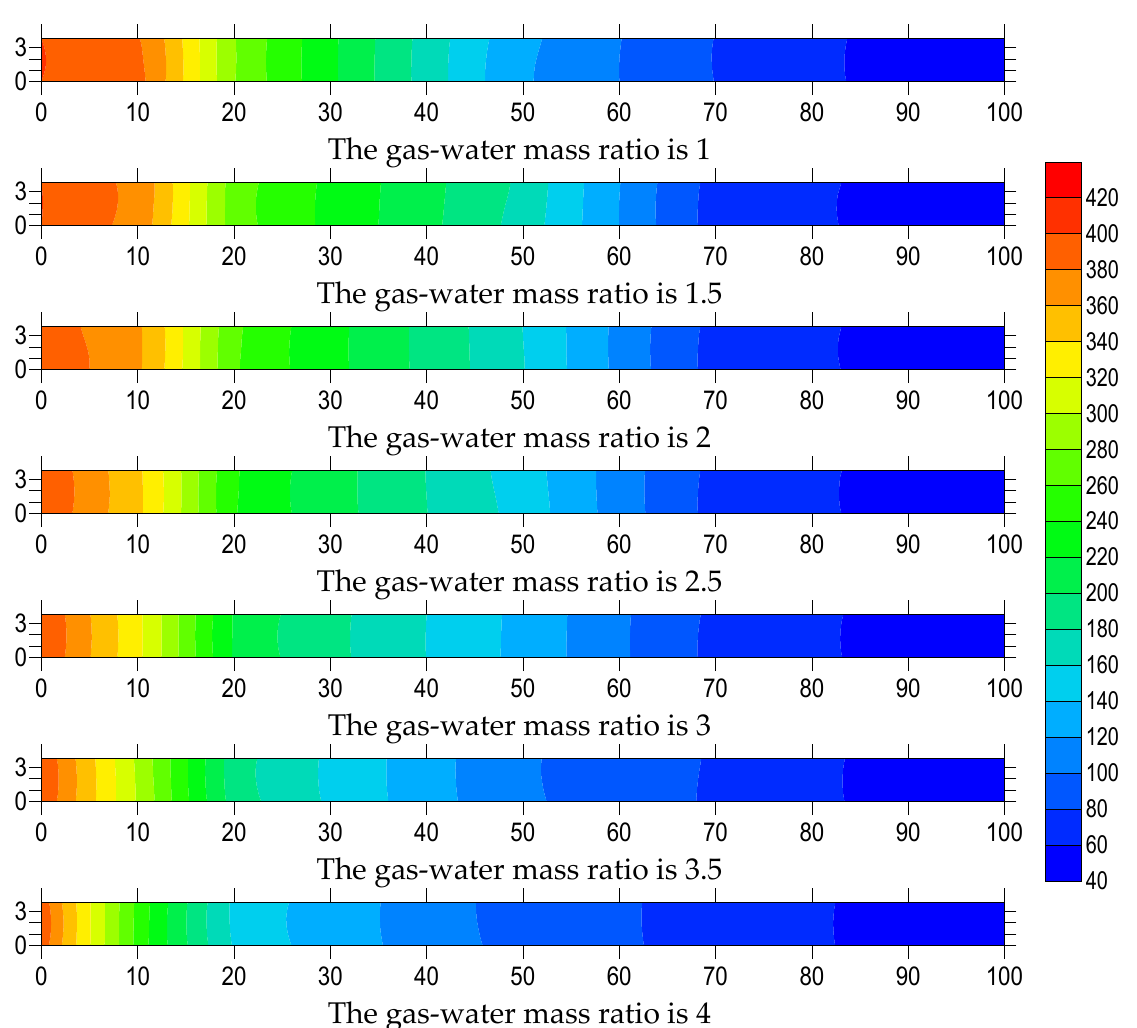
Figure 16. Real-time temperature distribution of supercritical multi-thermal fluid flooding. Figures 17 and 18 demonstrate that in the early stage of flooding, the supercritical multi-thermal fluid with different gas–water mass ratios could achieve higher oil recovery rates, and with the progress of flooding, the oil recovery rate gradually slowed down. Moreover, the lower the gas–water mass ratio, the higher the oil recovery rate in the early stage, and overall oil recovery rate was also higher than that of the supercritical multi- thermal fluid with a high gas–water mass ratio. With an increase in non-condensable gas in the supercritical multi-thermal fluid, the oil displacement efficiency decreased. When the water content reached 98%, the oil displacement efficiency was 90.72, 88.8, 86.3, 84.2, 82.71, 80.30, and 71.8%. Therefore, from the perspective of oil displacement efficiency, in these five experiments, the gas–water mass ratio in the supercritical multi-thermal fluid was optimal when it was about 1. In other words, when the proportion of oil was about 10%, the supercritical multi-thermal fluid produced by the reaction had the best oil displacement